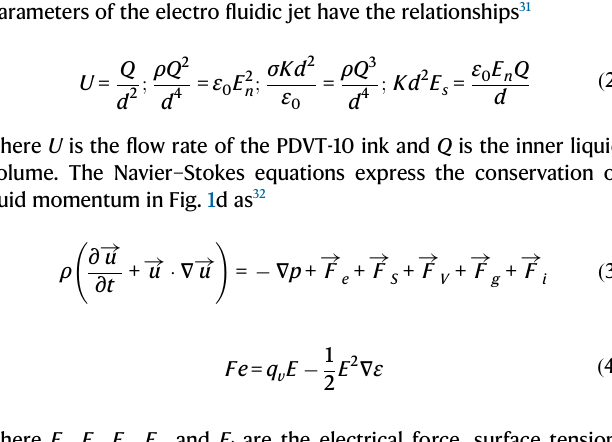
Fig. 1 | Schematic of the CFEJ printing system and process. a Schematic of the printing equipment and the coaxial nozzle. b Morphology of the coaxial jet during the printing process. c , d Schematic of the coaxial jet and forces acting on the